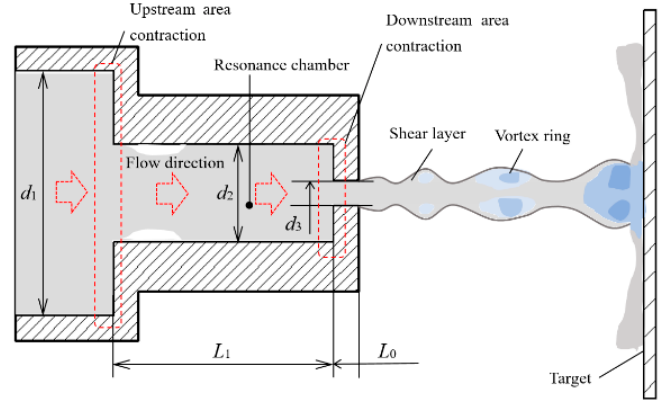
Figure 1. Structure diagram of an organ nozzle.